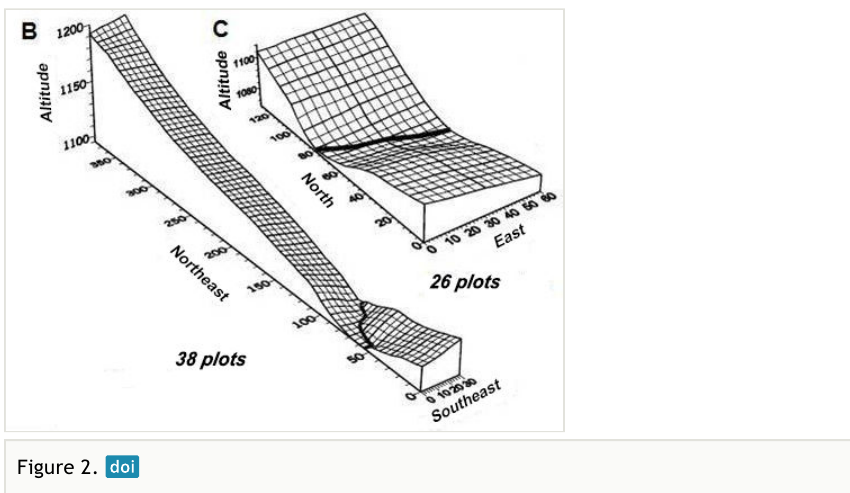
Surface grid of the sampled transects of each stand (B and C) studied in the forest of the PEQRB, in the municipality of Lavras, Minas Gerais State, Souheast of Brazil. The size of each plot in both stands was 30 x 10 meters. The spacing between grid lines is 5 meters. Adapted from Dalanesi et al.